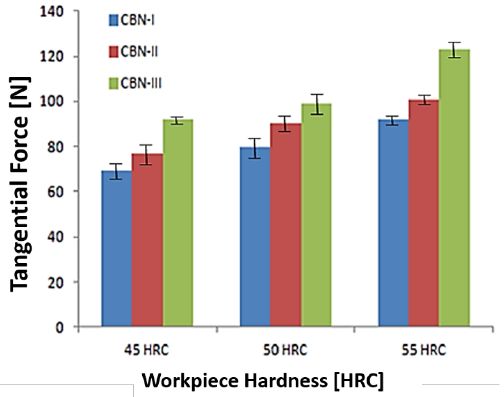
Figure 7. Comparisons of Tangential Force (F c ) with different CBN insert corresponding to workpiece Hardness. Table 11. Model of Thrust Force for CBN-I Insert.